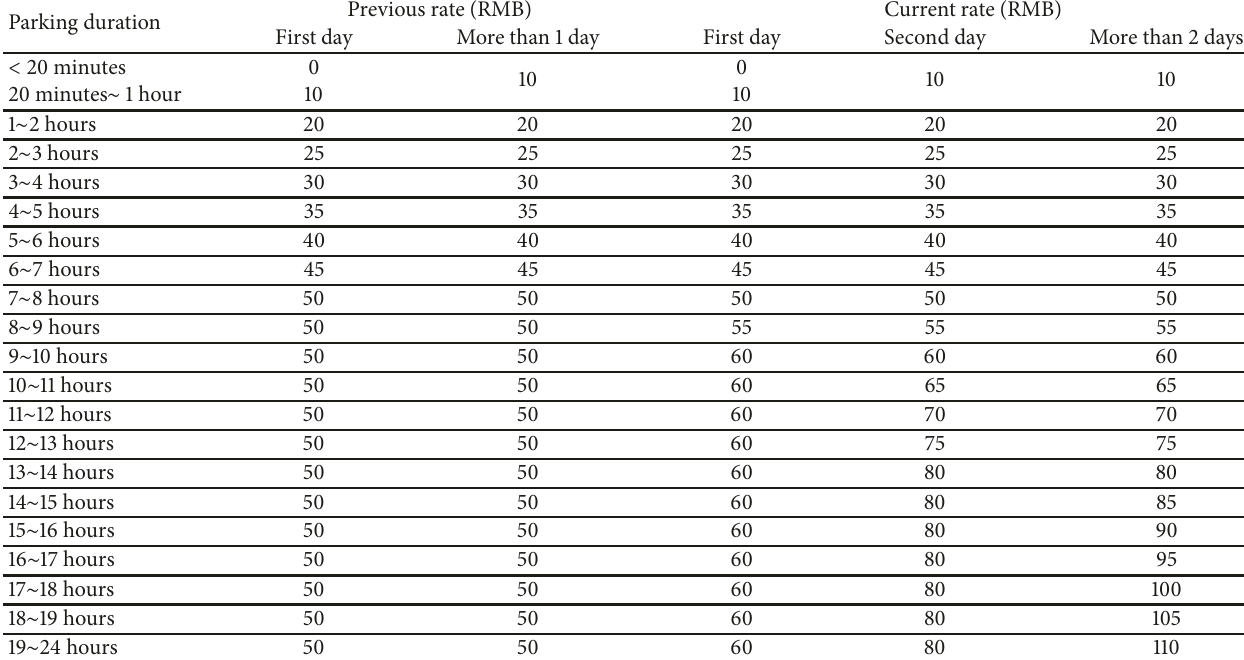
Table 1: Comparison of the T2 parking lot charging rate before and after price modification. Parking